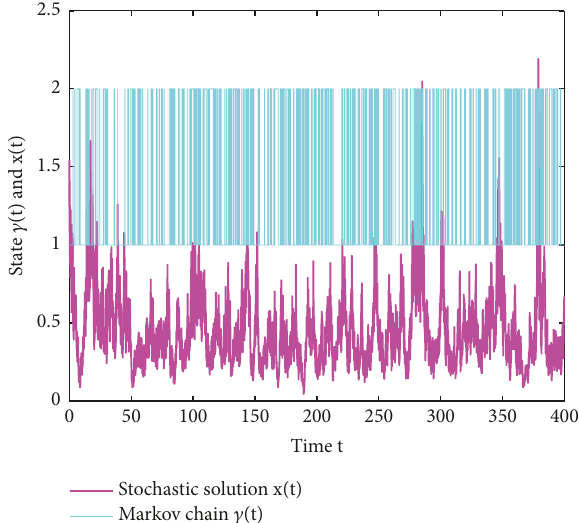
Figure 3: Stochastic trajectories of model (6) with parameters in Example 3.